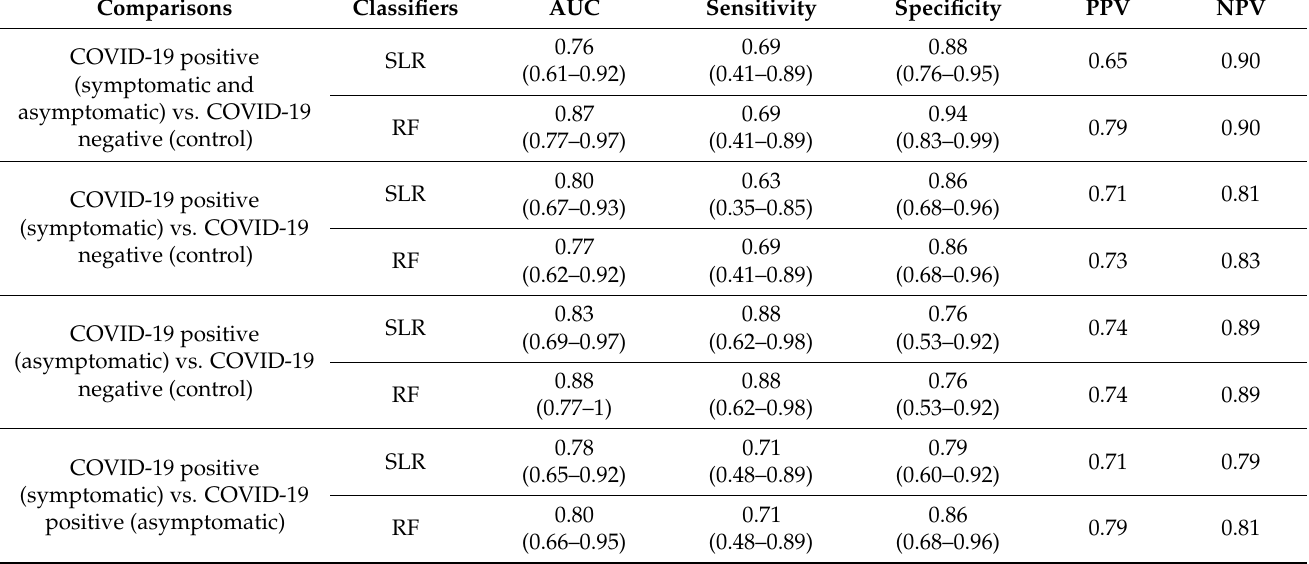
Table 2. Statistical results comparing different patient groups.